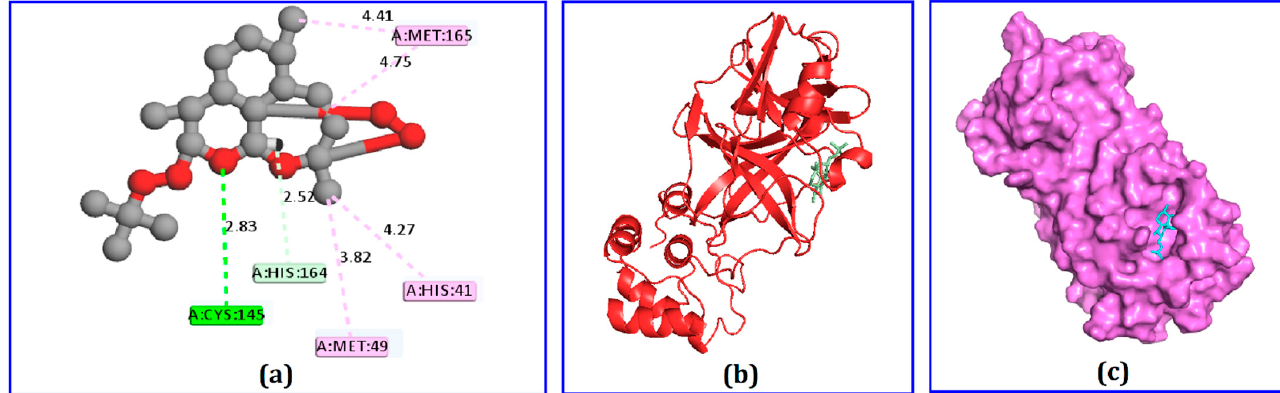
Figure 5. The interaction of dihydroartemisinin and main protease enzyme, ( a ) 2D interaction obtained from Discovery Studio, ( b ) 3D view, and ( c ) surface view.